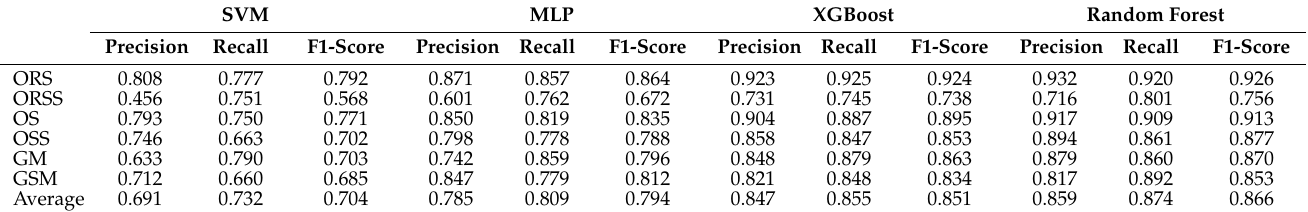
Table 3. Precision, recall and F1-scores for 5-fold-cross-validation over machine learning models. MLP XGBoost